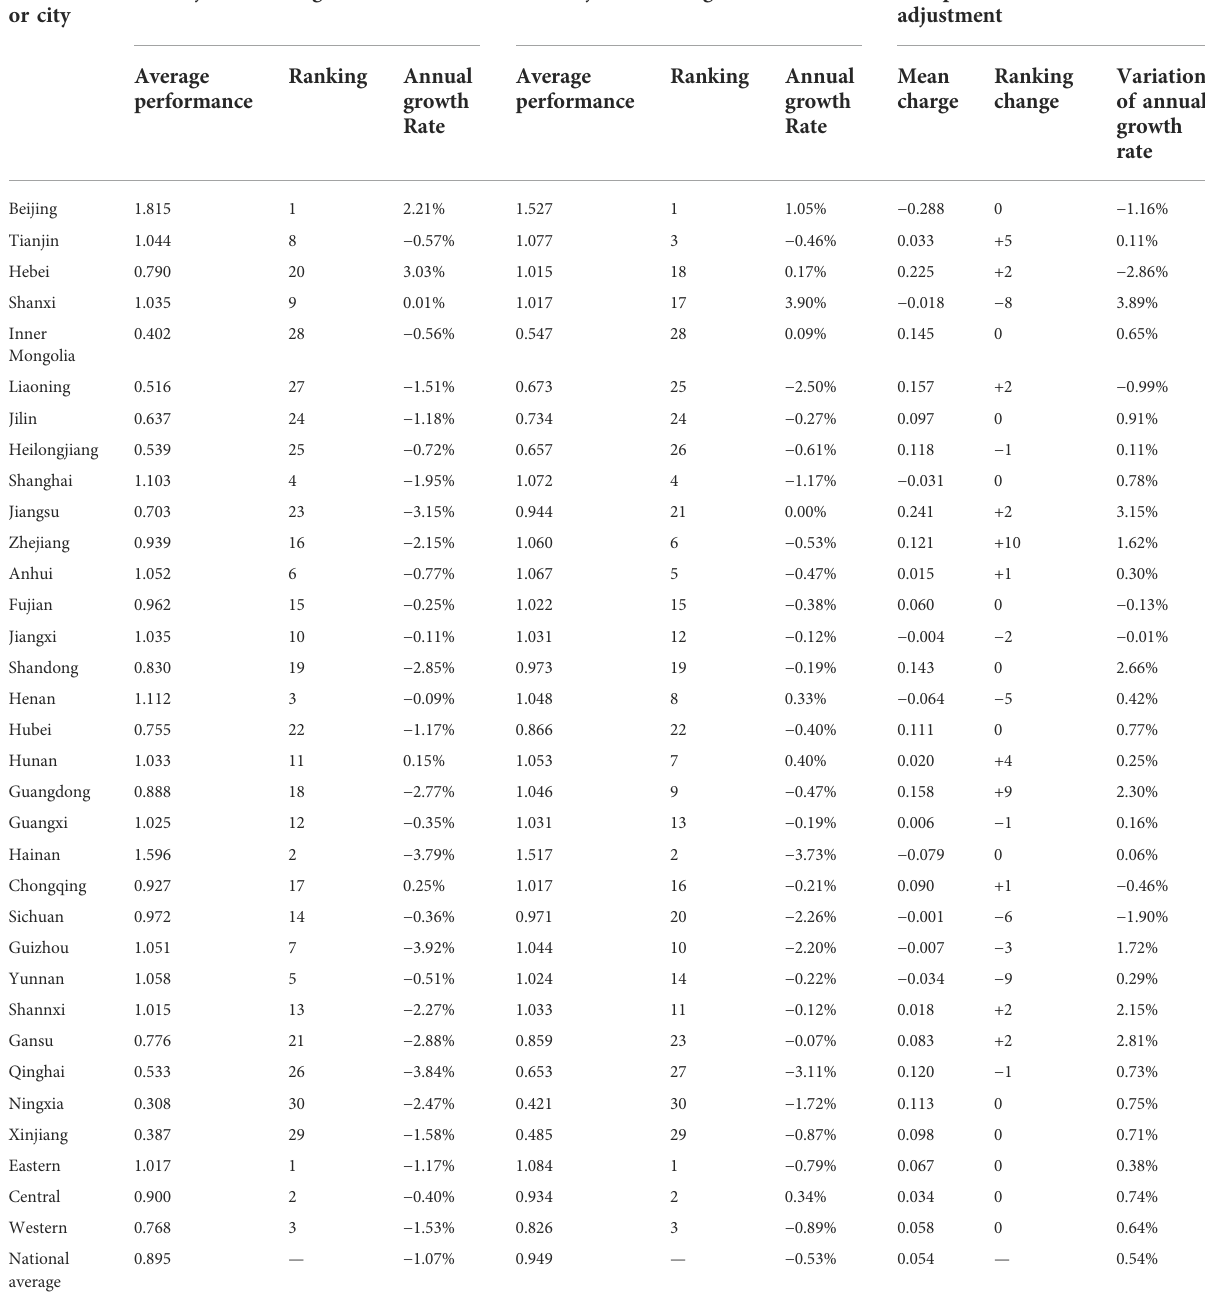
TABLE 5 Comparison of the results of the fi rst stage and the third stage. Province or